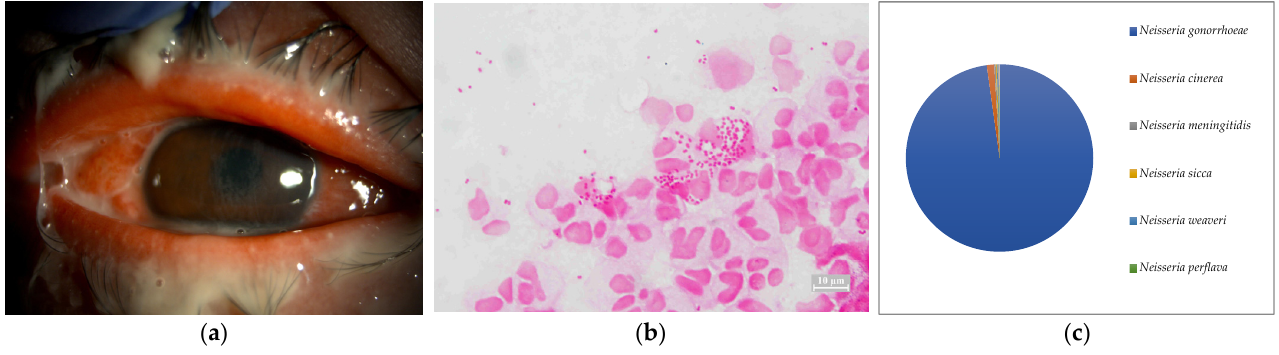
Figure 8. ( a ) Anterior segment photograph. Severe muco-purulent eye discharge and conjunctival hyperemia were found. The immune response caused corneal infiltration. These findings are mostly suggestive of gonococcal keratoconjunctivitis. ( b ) Smear microscopy. Gram staining of ocular surface aspirates containing eye discharge detected abundant Gram-negative diplococci. ( c ) Nanopore sequencing results (relative abundance) of Case 8. An overwhelming majority of Neisseria gonorrhoeae was detected by MinION.